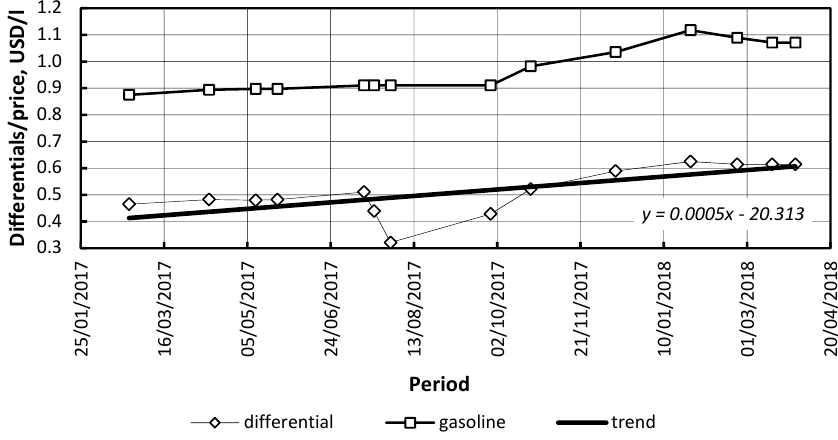
ff erentials (the di ff erence between gasoline and LPG prices) in Figure 2. Fuel price differentials (the difference between gasoline and LPG prices) in Ukraine. Figure 2. Fuel price di